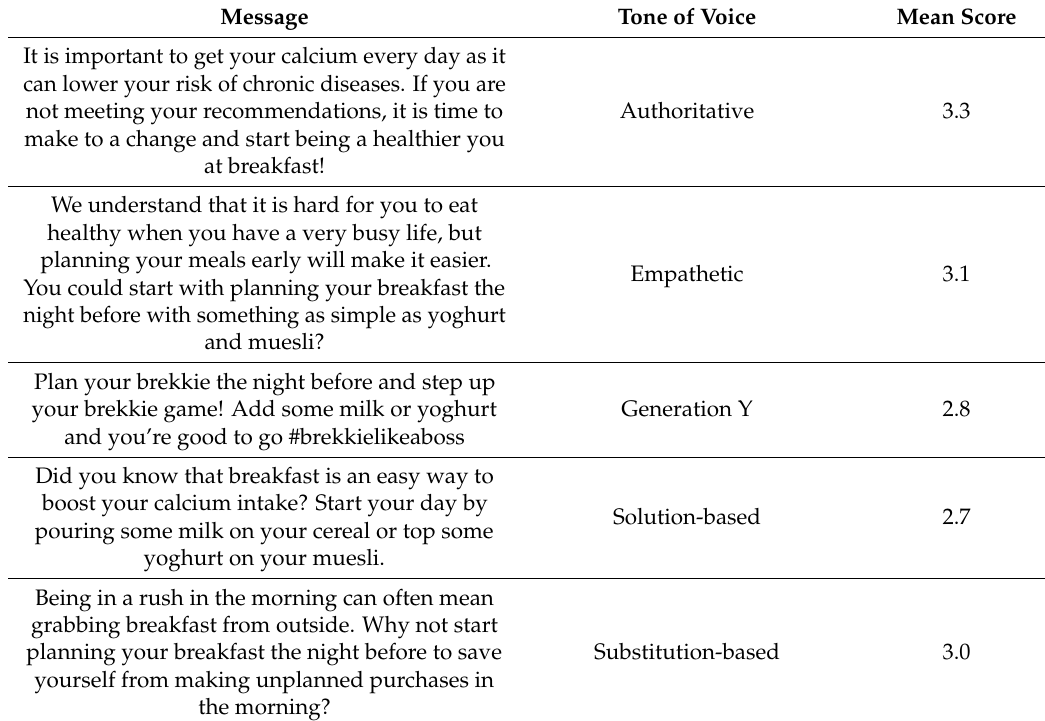
Table 2. Participants rating of messages as the most motivating to increase calcium-rich food and the mean score (1 is the highest motivation and 5 is the lowest motivation